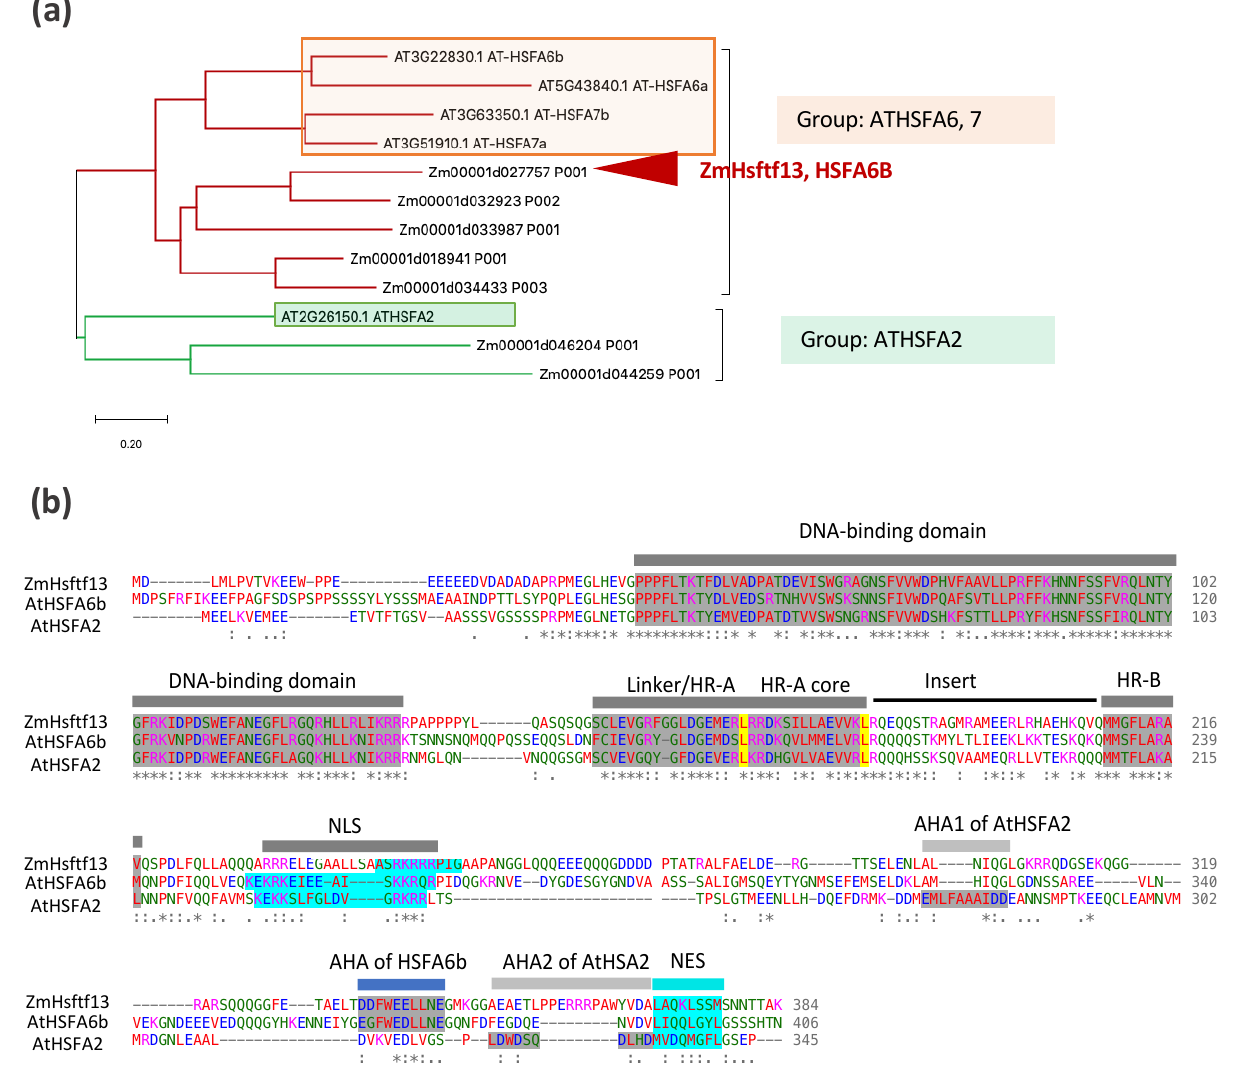
Figure 4. Phylogenetic relationship and domain analysis of Hsftf13. ( a ) Amino acid sequence alignment of the Hsftf13 sub- group genes in Arabidopsis and maize. In this clade, there is two subfamily HSF genes in Arabidopsis (HSFA2 and HSFA6,7). Two maize HSFs in subgroup HSFA2 and five HSFs in the HSFA6,7 subgroup, including Hsftf13. The evolutionary anal- ysis was conducted in MEGA X (https://www.megasoftware.net) by using the maximum likelihood method and JTT (Jones-Taylor-Thornton) matrix-based model. The tree with the highest log likelihood is shown. ( b ) Amino acid sequence alignment and major domains in those HSFs. AHA motifs, activation domain, and characterized by short peptide motifs. The oligomerization domain HR-A/B is characterized by the heptad pattern of hydrophobic residues. NLS represents nuclear localization signal, and NES indicates nuclear export